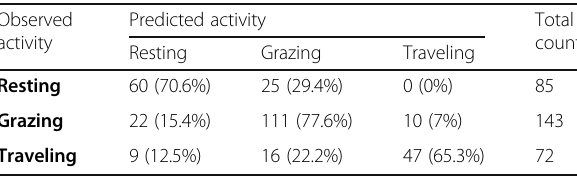
Table 2 Frequency count and percentage of field observed activities in the predicted activity categories according